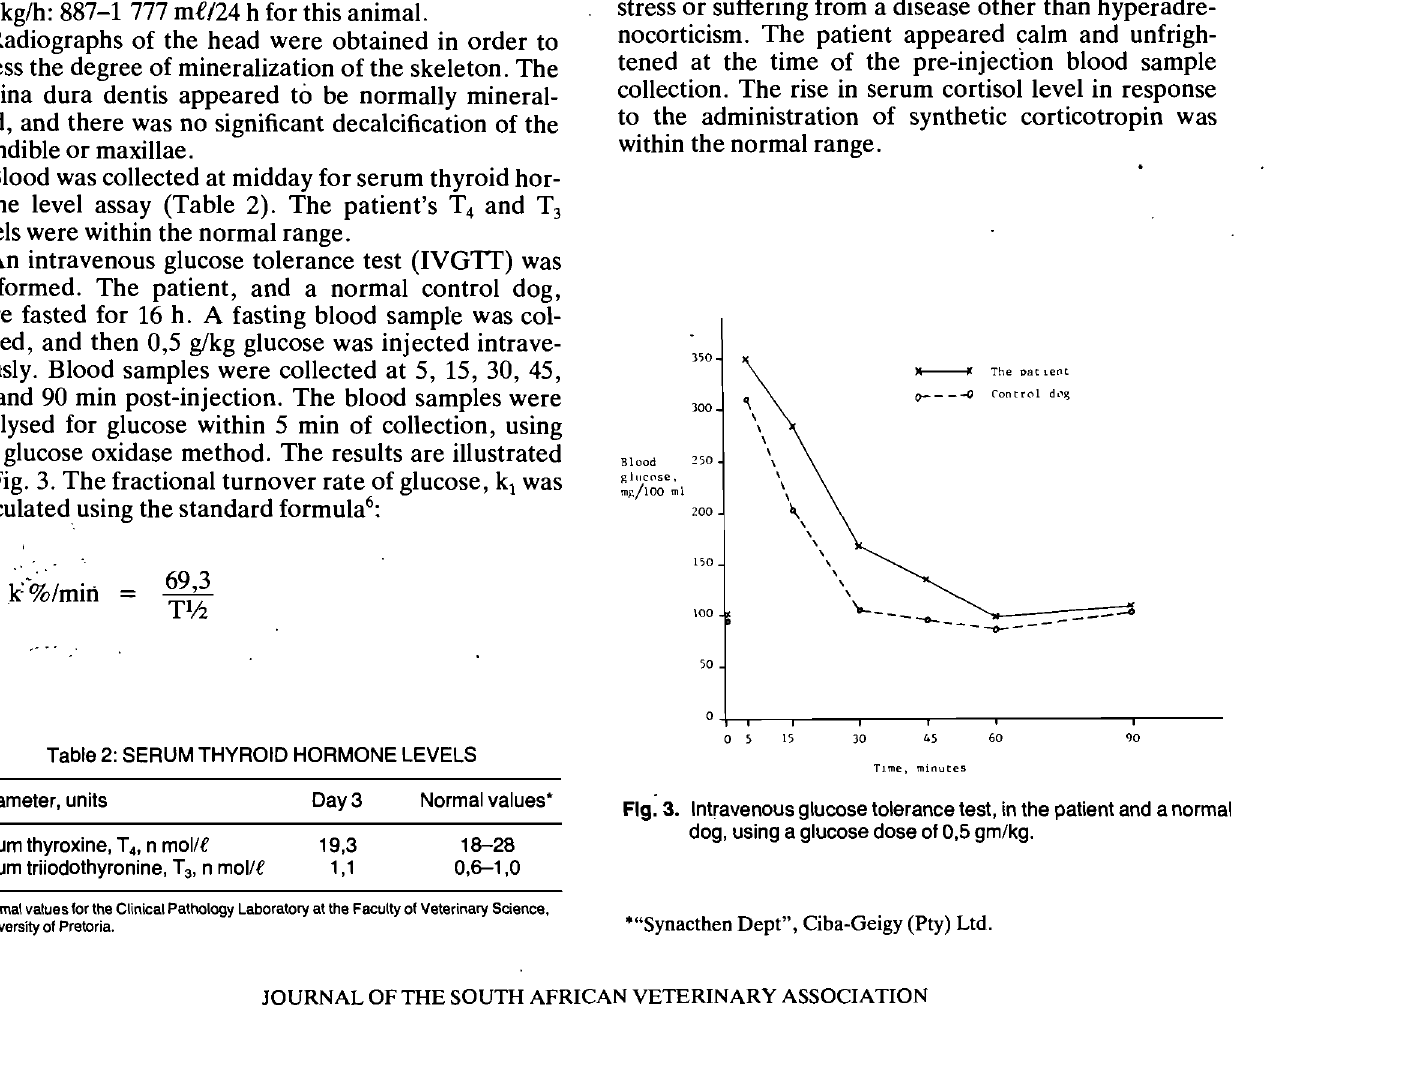
Fig. 3. Intravenous glucose tolerance test, in the patient and a normal dog, using a glucose dose of 0,5 gm/kg.